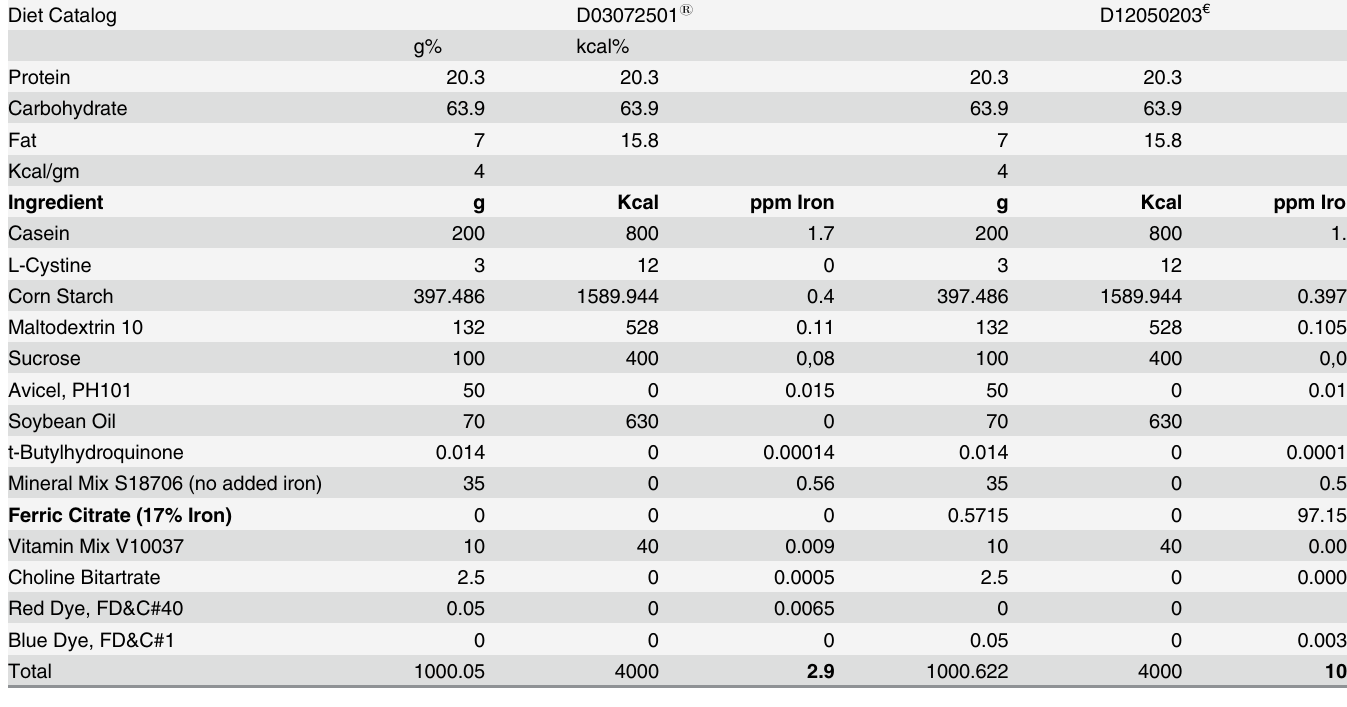
Table 2. Diets used in the low – iron diet experiments. These diets were similar to those used by Minamiyama [14]. See